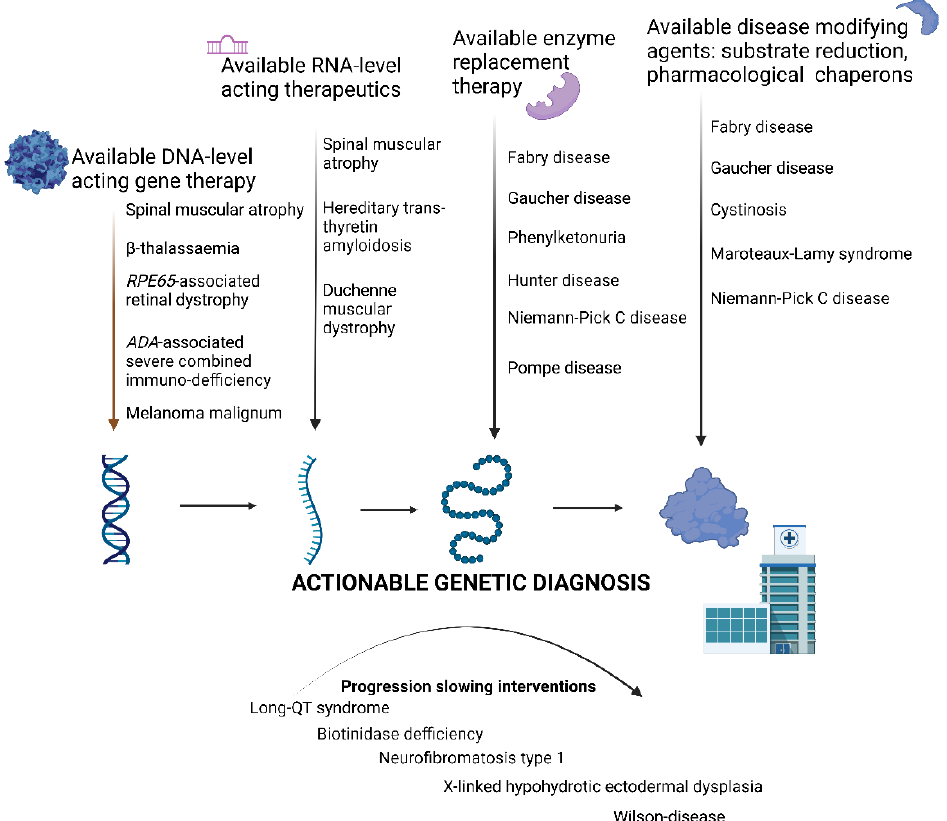
Figure 3. Actionable genetic diagnosis — identification of certain genetic diagnoses opens the pathway for either disease-specific therapy or medical actions that may significantly lower the burden of phenotype and enhance the quality of patients’ life. Created with BioRender.com (accessed on 16 November 2022).